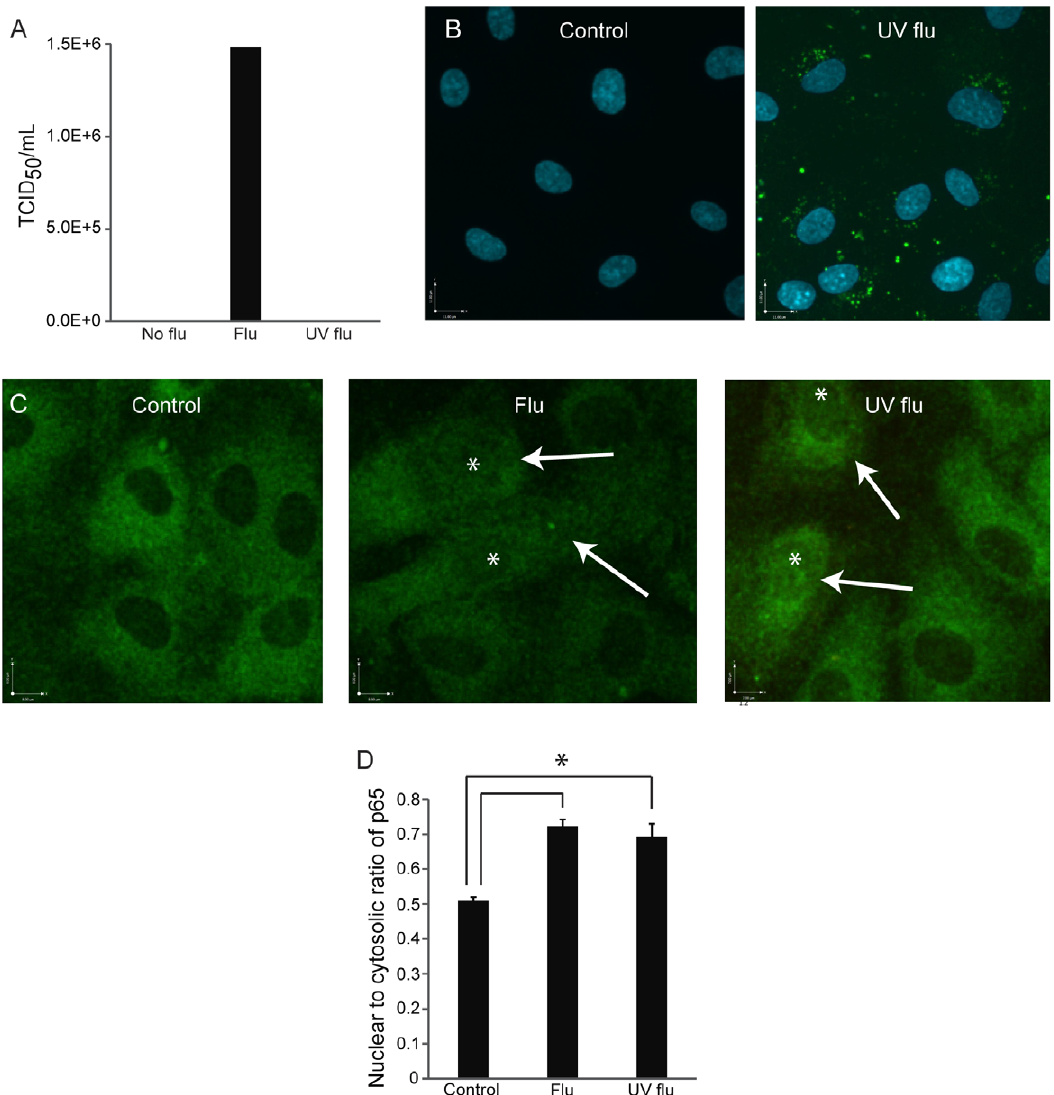
Figure 4. Characterization of replication-deficient virus. (A) Influenza irradiated with ultraviolet light (UV flu) cannot replicate. Influenza (40 HAU/100 000 cells) was irradiated with UV light for 10 minutes before viral titer was measured using the TCID 50 assay as in Figure 1A. Results are representative of 2 experiments. (B) Viral proteins are expressed in endothelial cells infected with UV-irradiated influenza. Influenza was given at an MOI of 8 for 12 hours. Nuclei are stained with DAPI and viral nucleoprotein is shown in green. Images are representative of 2 experiments. Immunofluorescent images (C) and quantitation (D) showing the ratio of nuclear to cytosolic p65, a measure of NF k B activation, in cells infected by influenza after 12 hours. Influenza was given at an MOI of 8. Arrows indicate infected cells, while asterisks denote their nuclei. P65 is shown in green. Infected cells were identified by immunofluorescence for influenza viral protein M1 (not shown). Images are representative of 4 experiments; data are mean and standard error, *p , 0.05 for live flu and UV flu vs. control (uninfected